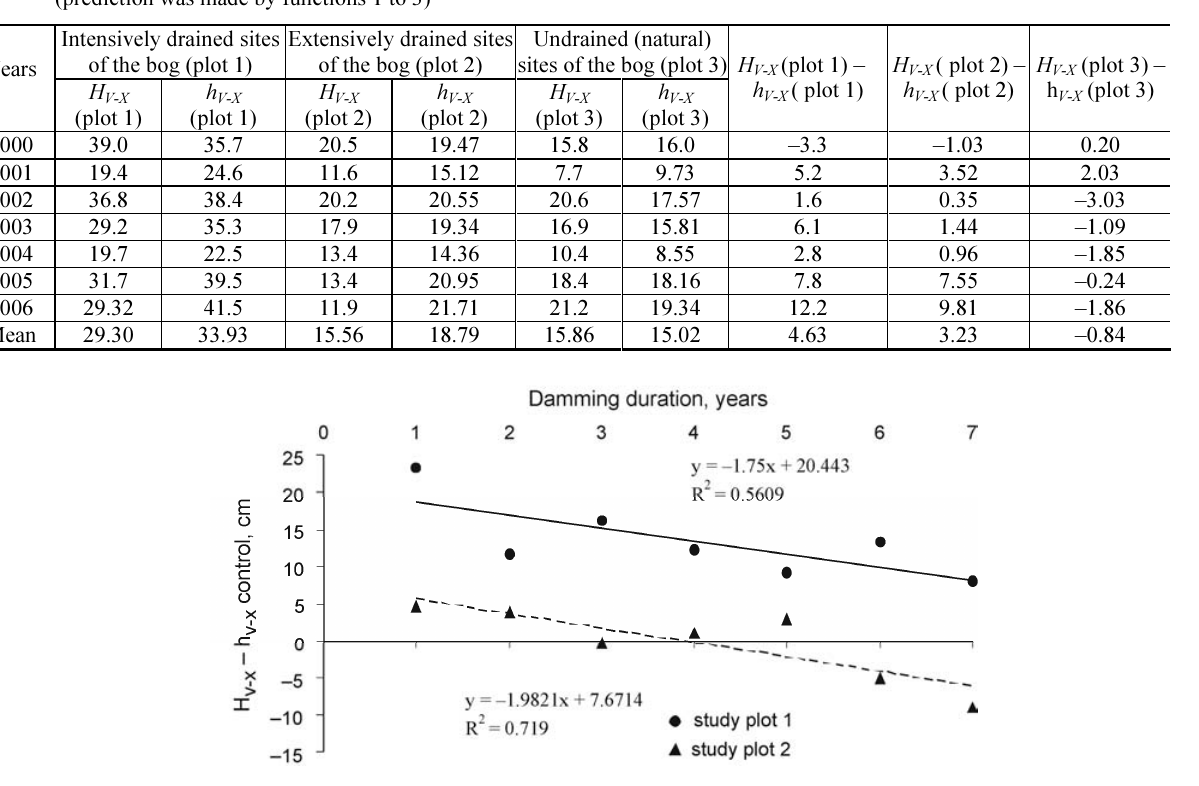
Fig. 7. Variation of difference in the water table depth between the intensively drained plots and the controls (filled cycles) and between extensively drained plot and the controls (filled triangle) (Y axis: H V-X – h IV-X control), depending on the duration of